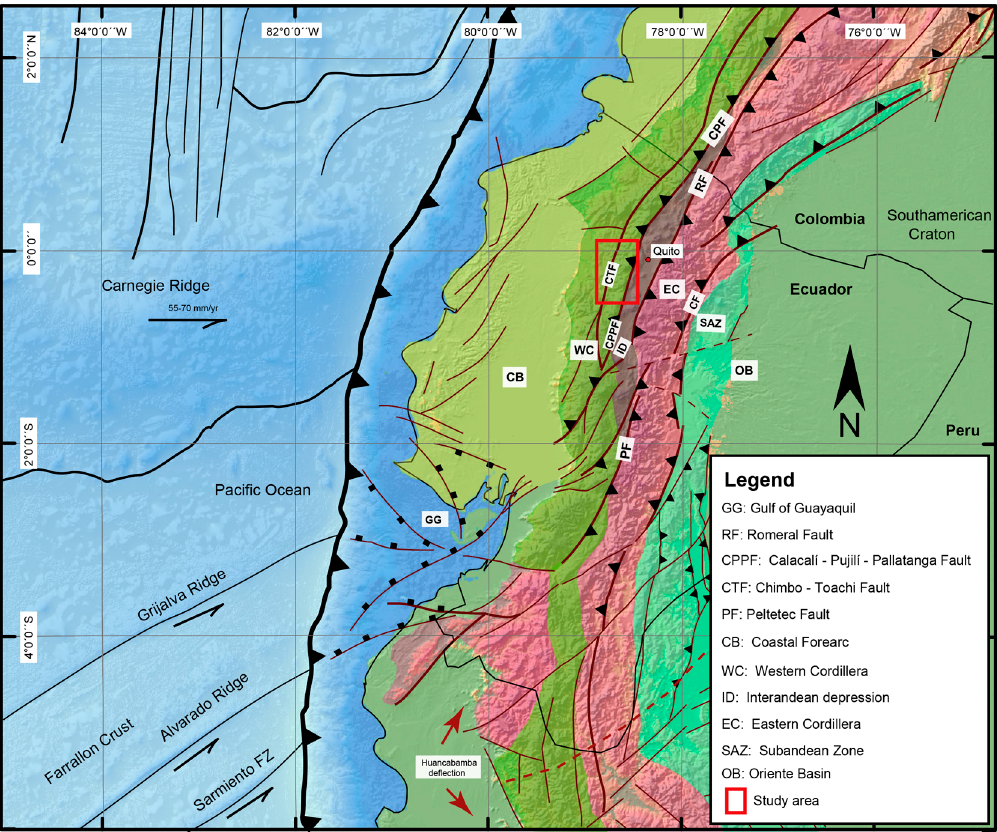
Figure 1. Lithotectonic map of Ecuador (modified from Luzieux et al. [1]) and location of the study area.